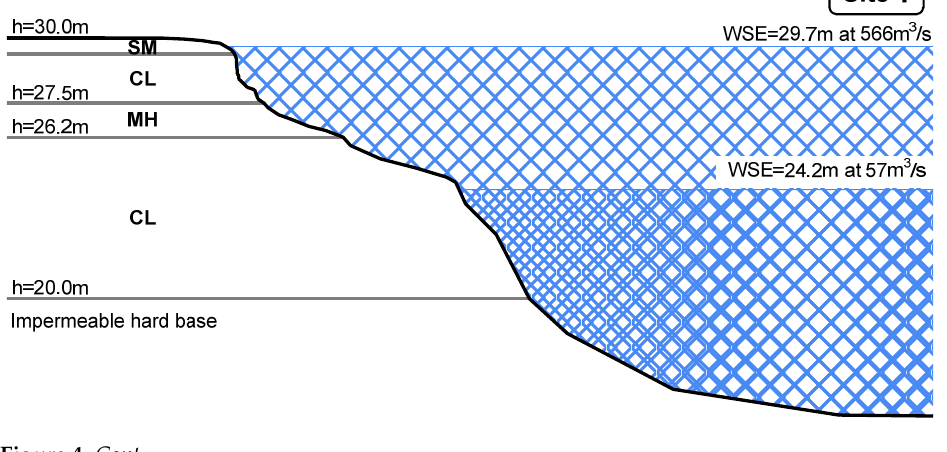
Figure 4. Riverbank cross-section and profile with water surface elevation (WSE) locations.